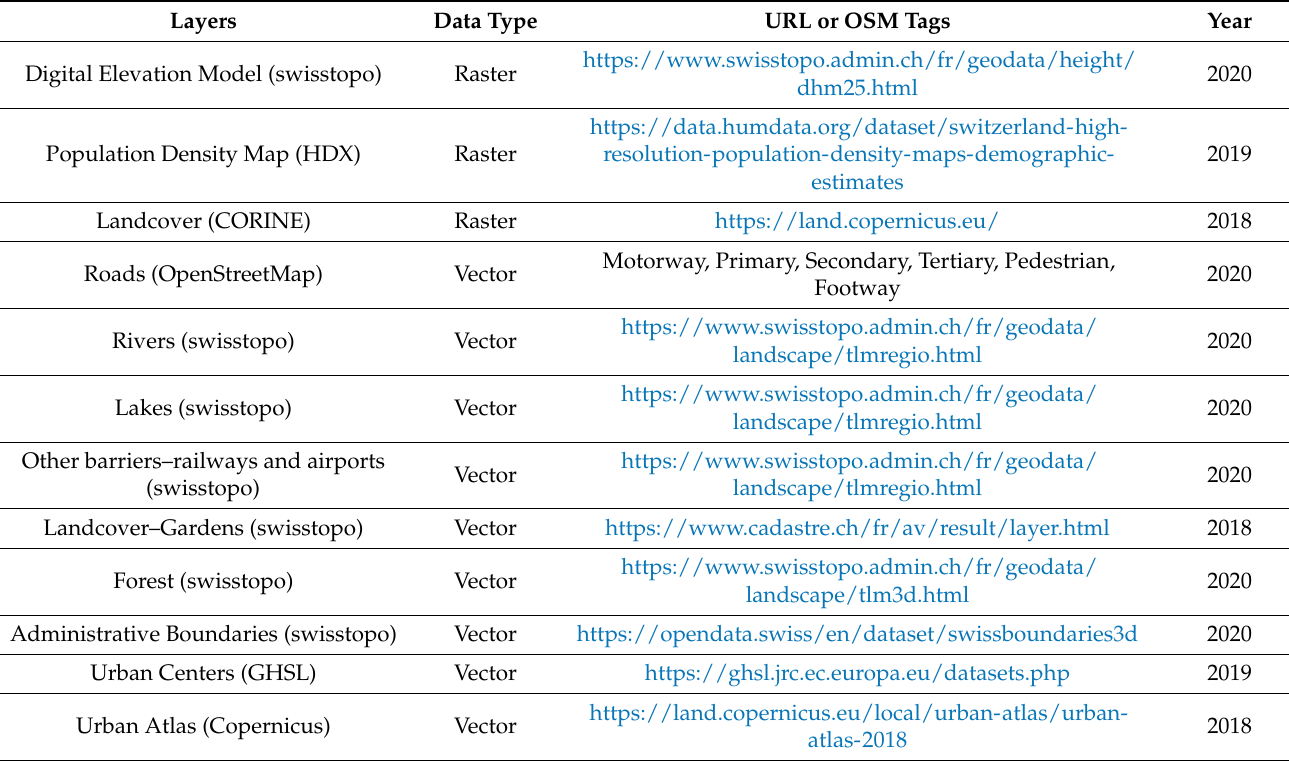
Table 1. Geospatial layers used for analyzing the physical accessibility to public green spaces in Switzerland. Layers Data Type URL or OSM Tags Digital Elevation Model (swisstopo) Raster